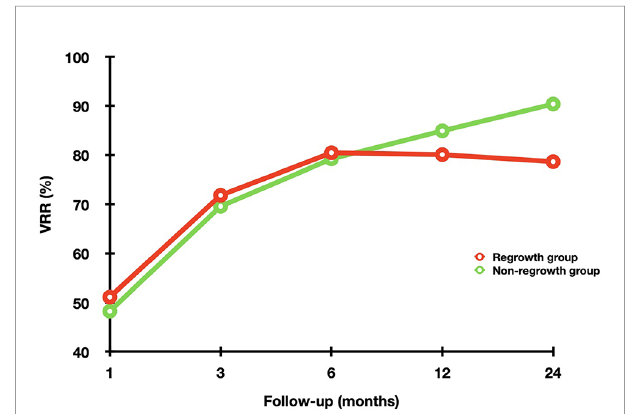
FIGURE 1 | The changes of VRR in the non-regrowth and regrowth groups at each follow-up point after RFA. In the fi rst 12 months, VRR in the two groups were nonsigni fi cant (all P >0.05). However, at 24 months after RFA, VRR in the non-regrowth group were signi fi cantly larger than that in the regrowth group ( P = 0.002).